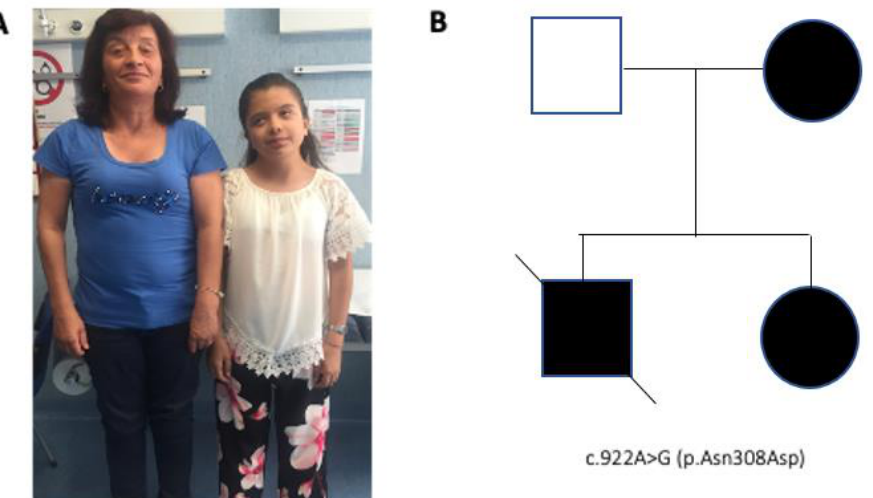
Figure 1. ( A ) Patient (right) at age 13 years and her mother (left) show typical features of NS, note the short stature and common facial features (ptosis, hypertelorism, downslanting palpebral fissures and low-set ears) and a short webbed neck; ( B ) pedigree of the family in which NS cosegregated with the recurrent PTPN11 mutation.